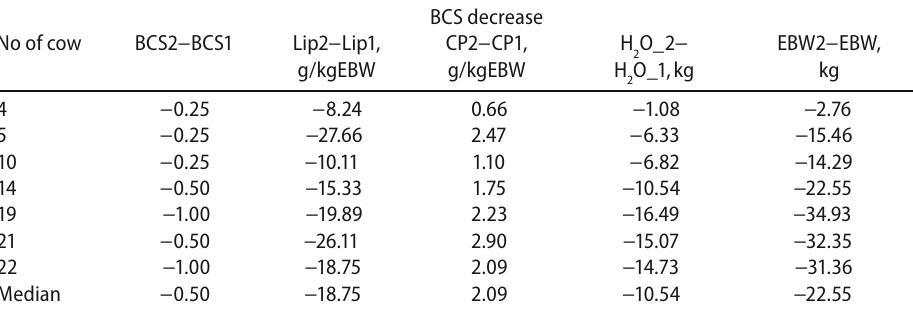
Values of differences of parameters and their medians for cows at I phase of lactation whose BCS decreased